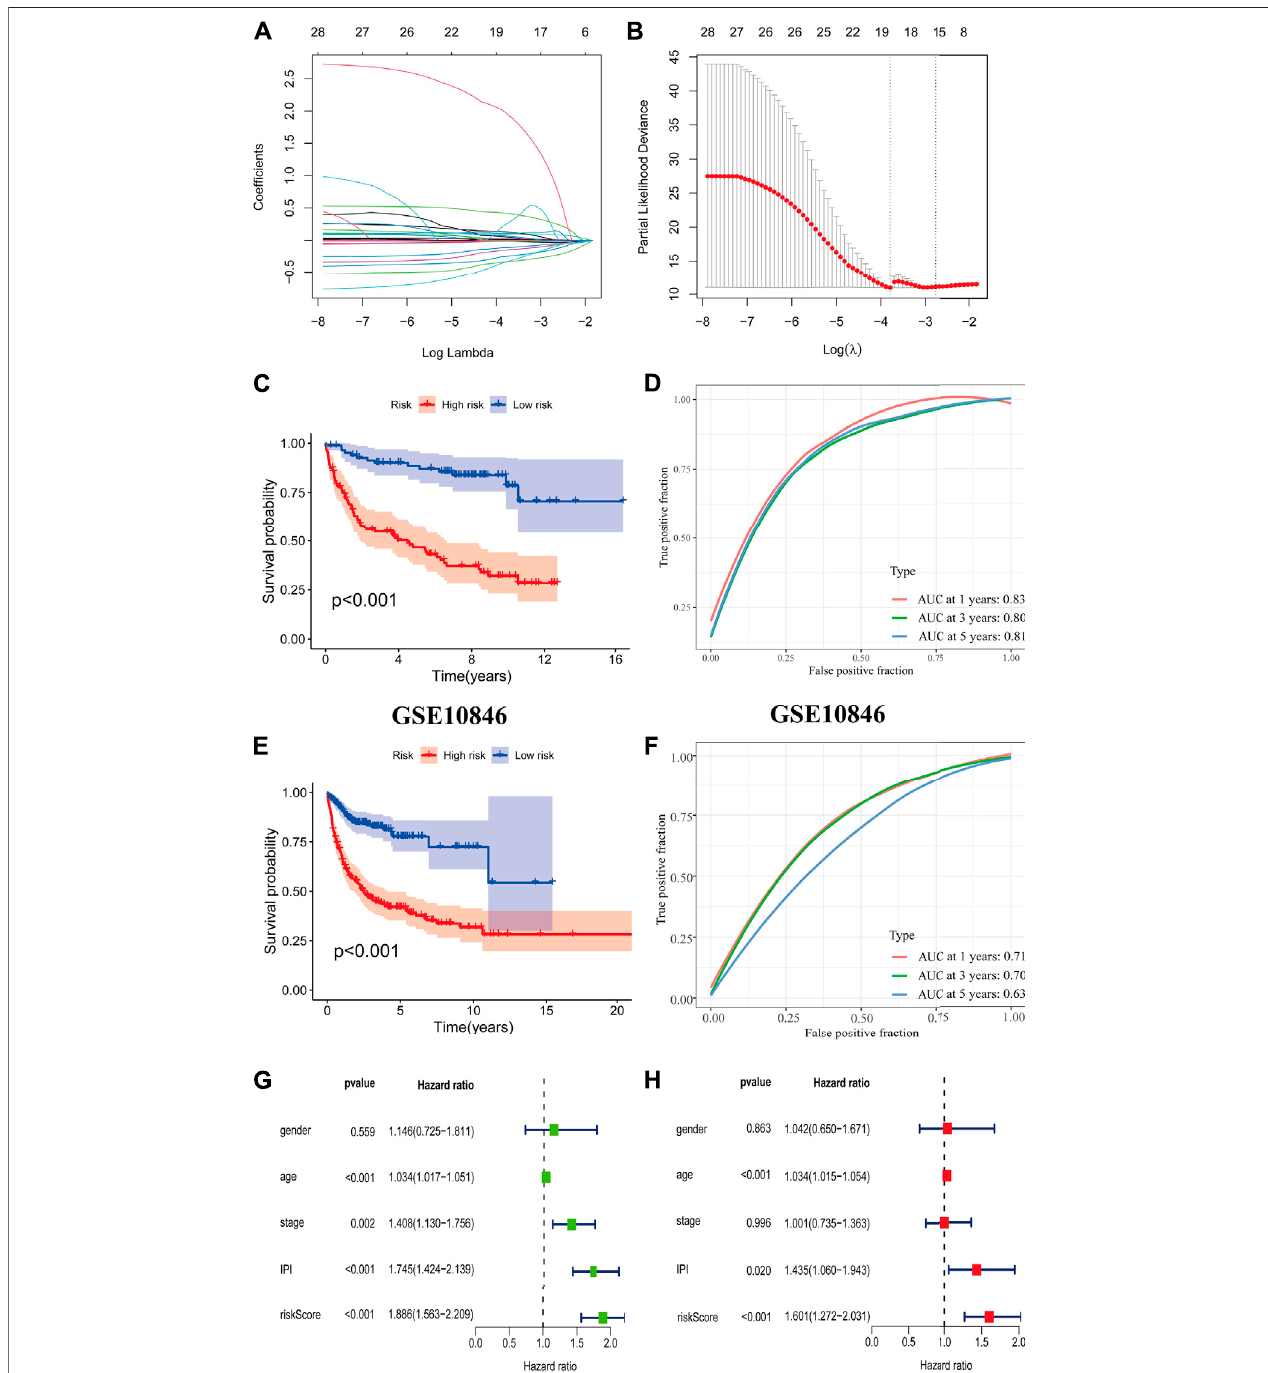
FIGURE6| Construction andvalidationofprognostic model. (A,B) Coef fi cients ofselectedcharacteristicsareshown bythelambdaparameter,thehorizontalaxis represents the value of the independent variable lambda and the vertical axis represents the coef fi cient of the independent variable; partial likelihood deviation is plotted against log( λ ) using the lasso Cox regression model. (C,E) Survival analysis curves for high and low risk score groups. (D,F) ROC curves of the prognostic model. (G) Univariate Cox regression analysis of DLBCL risk factors. (H) Multivariate Cox regression analysis of DLBCL risk factors.